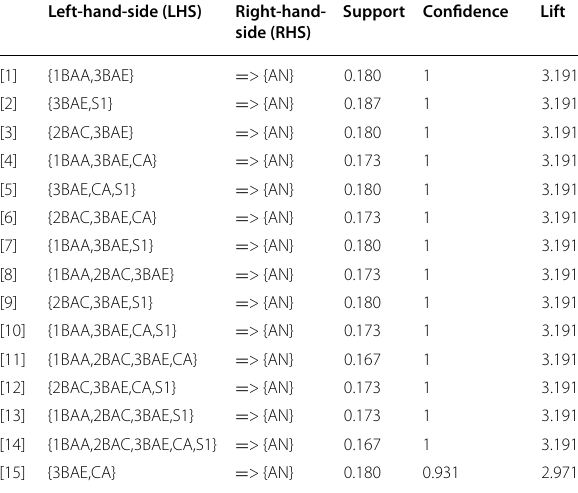
Table 11 Strong Association Rule with RHS item “AN” Left‑hand‑side (LHS) Right‑hand‑ Support Confidence Lift side (RHS)